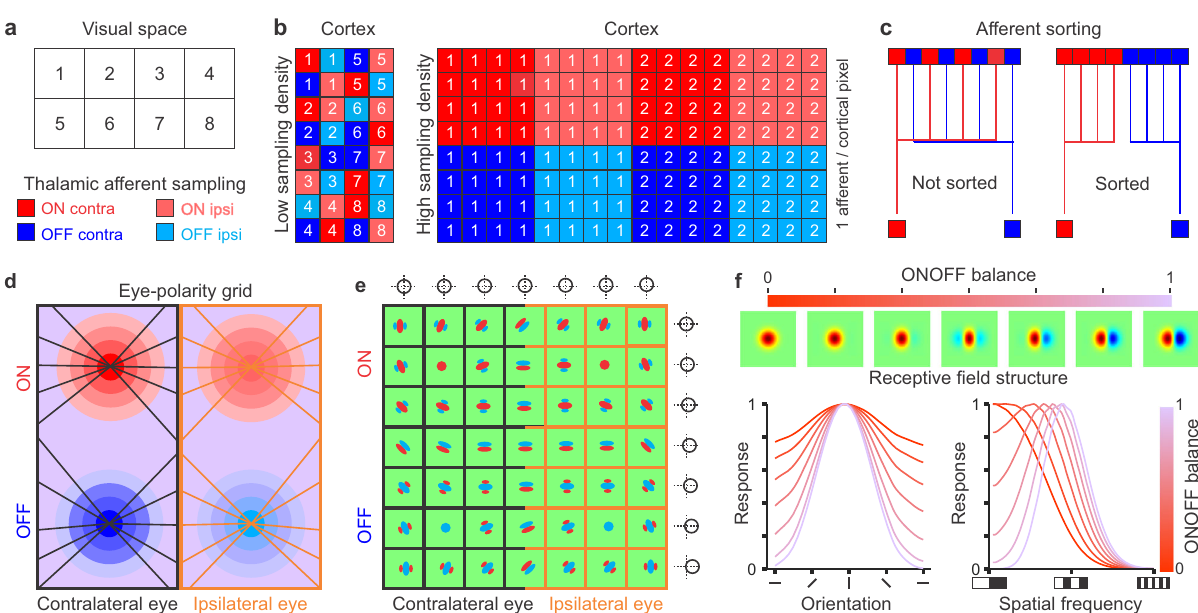
Fig. 1 Theory of cortical map formation. a Cartoon illustrating 8 adjacent positions in visual space that can be discriminated as separate by visual cortex (e.g. two stimuli are perceived as separate only if they fall in different squares). The theory assumes that each square position is sampled by four different types of thalamic afferents that signal the onset of light (ON: red) or dark stimuli (OFF: blue) projected on the contralateral (contra: high contrast) or ipsilateral retina (ipsi: low contrast). The size of the squares represents the visual resolution (receptive fi eld size) of the thalamic afferents. b Cartoon illustrating a small cortex sampling each spatial position with four afferents (left) and a larger cortex sampling each spatial position with 64 afferents (right). c Cartoon illustrating the afferent sorting. d The theory assumes that the visual cortex sorts afferents with overlapping receptive fi elds by eye input and contrast polarity, forming an eye-polarity grid with separate regions for ON-contra, OFF-contra, ON-ipsi, and OFF-ipsi afferents that are linked by iso- orientation lines. e This afferent sorting makes cortical receptive fi elds become dominated by eye input and ONOFF polarity. Because afferents with different eye input are better matched in retinotopy than afferents with different polarity, retinotopy changes slower with cortical distance across the eye than ONOFF polarity border (circles and crosslines at panel outer borders illustrate changes in receptive fi eld position). f The theory predicts that increases in ONOFF response balance are associated with increases in stimulus selectivity. The top panel shows an increase in ONOFF response balance from ON dominated to equal ON and OFF subregion strength. The bottom panel illustrates how the increase in ONOFF response balance increases orientation selectivity (left), bandpass tuning and spatial resolution